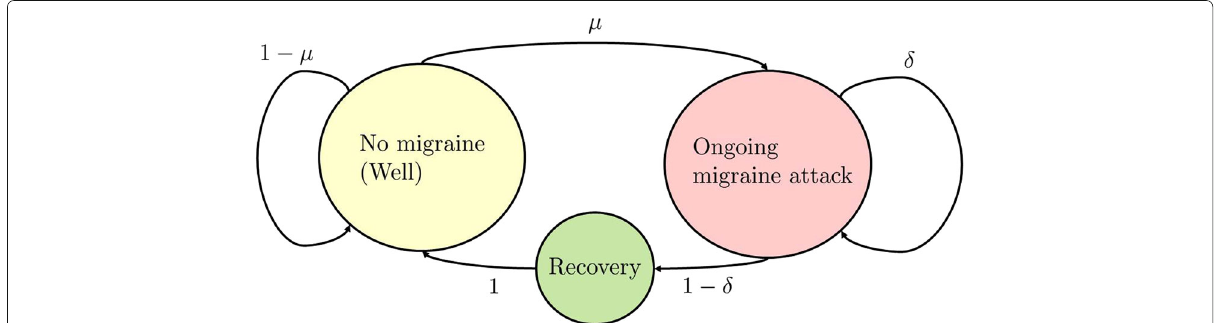
Fig. 1 Simple Markov chain model of the progression of migraine attacks. The transition probabilities μ and δ represent the probability of onset of a migraine attack – conditioned on being susceptible – and the probability that an ongoing attack will continue, respectively. We assume that each patient may have individual transition probabilities. The non-clustering assumption excludes μ (cid:2)= δ in general. MM – interpreted within this simple model – postulates that women with MM deviate from the base-model above, and instead have two distinct migraine probabilities: μ NM which represents her probability of migraine attack-onset outside her menstrual window, and μ M which represents an elevated migraine attack-onset probability during their menstrual window. That is, MM is present when μ M > μ